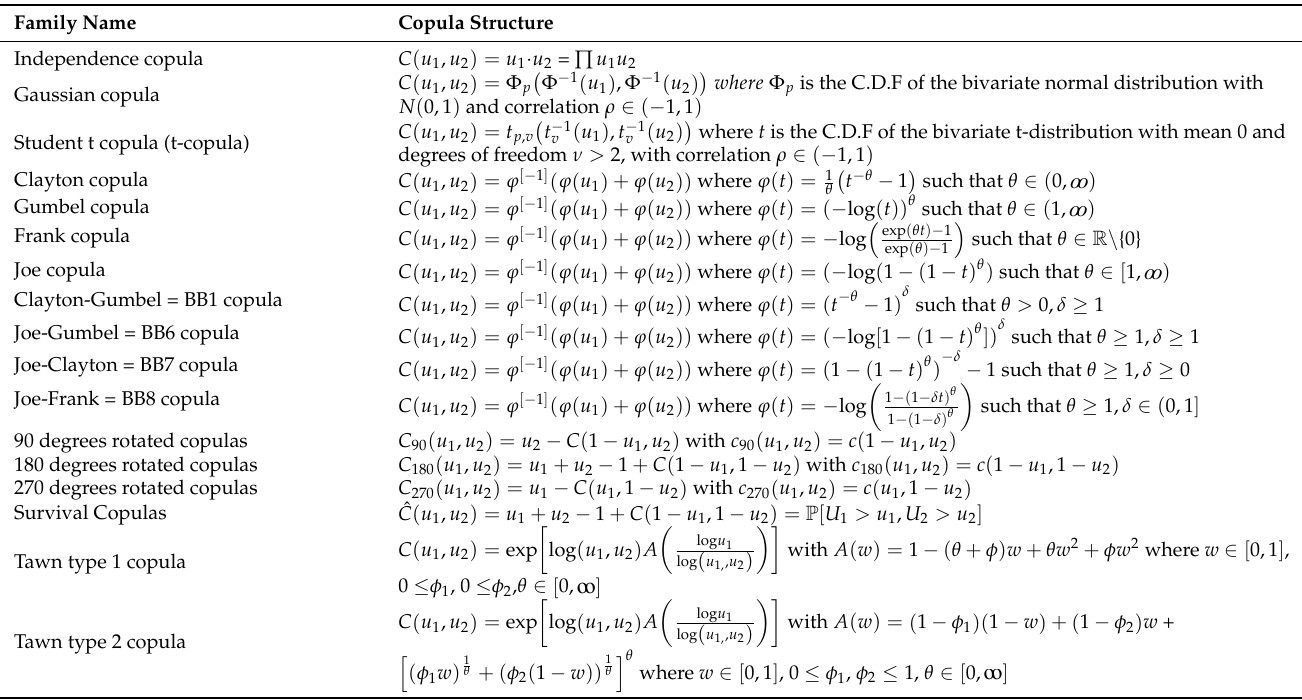
Table 1. Bivariate copula structures.